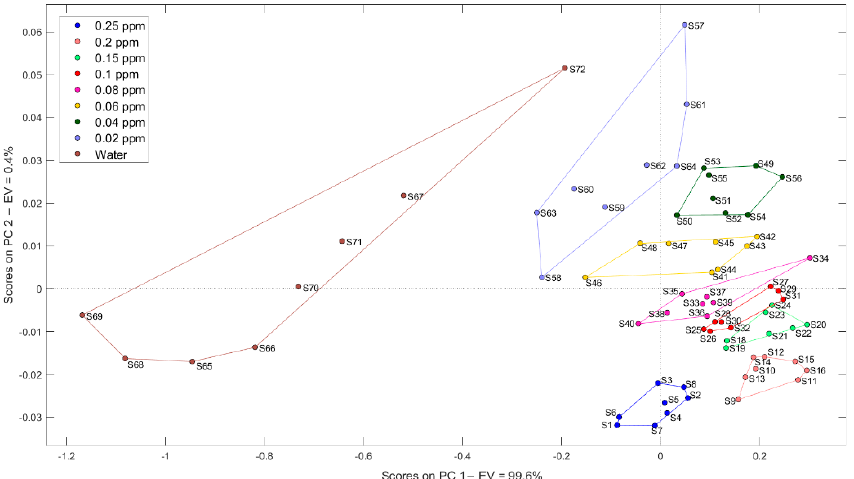
Figure 8. PCA plot by applying the carbon electrode (C110) to discriminate different Curathane concentrations against distilled water solution.